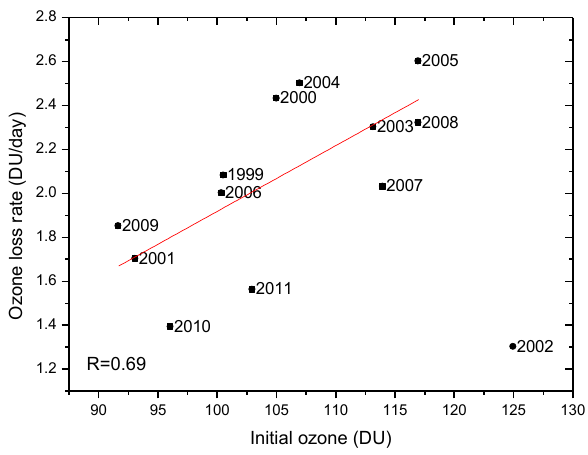
Fig. 7. Ozone loss rate versus the amount of ozone present before the direct ozone depletion starts (1 August) for all years of mea- surements. The correlation coefficient shown was obtained without Figure 7. Ozone loss rate versus the amount of ozone present before the direct ozone 3 inclusion of the anomalous year depletion starts (1 st of August) for all years of measurements. The correlation coefficient 4 written was obtained without inclusion of the anomalous year 2002. 5